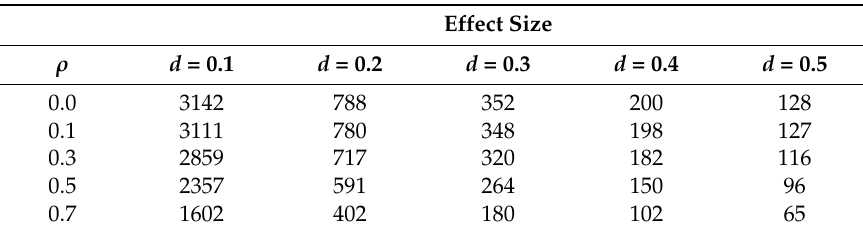
Table 2. Relationship between sample size required for 80% statistical power, effect size of treatment, and correlation between covariate and outcome measure. Effect Size ρ d = 0.1 d = 0.2 d =